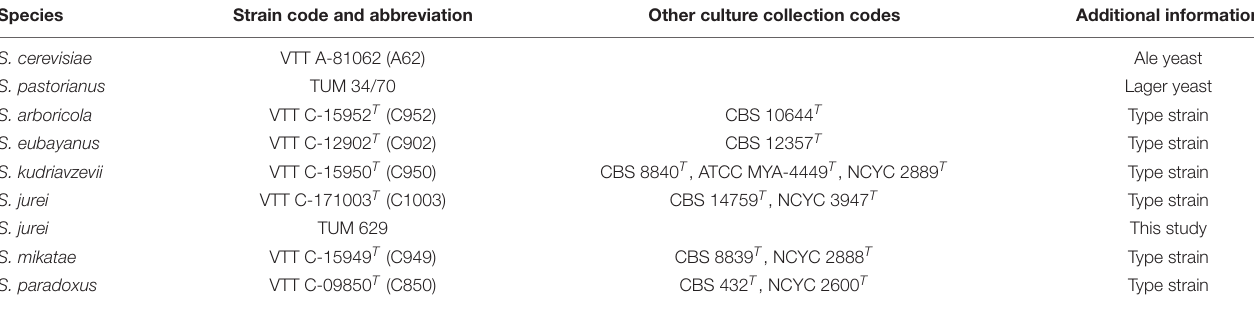
TABLE 1 | Strains used in this